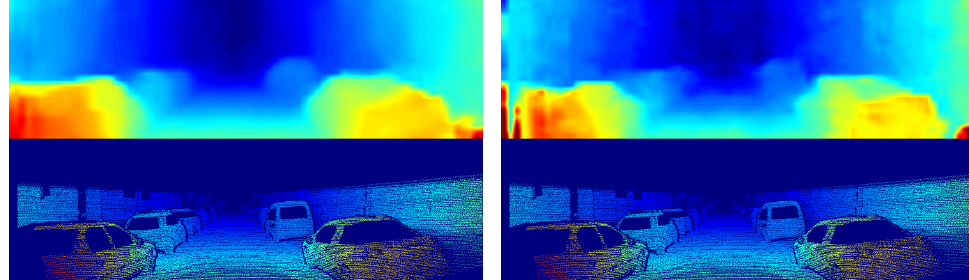
Figure 1. Disparity inference over the image pair 172 of the Kitti 2012 dataset [17]. ( Left ) disparity estimation using anytime-stereo stage 1. ( Right ) disparity estimation using stereonet. The disparity groundtruth is at the bottom of each